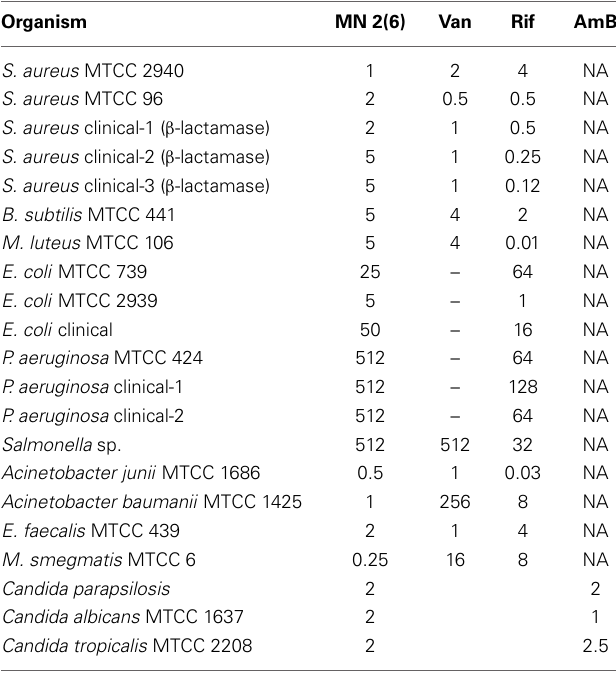
( Table 3 ). The partially purified product extracted with resin pound was found to have a Rf value of 0.78 (Figure S1). The